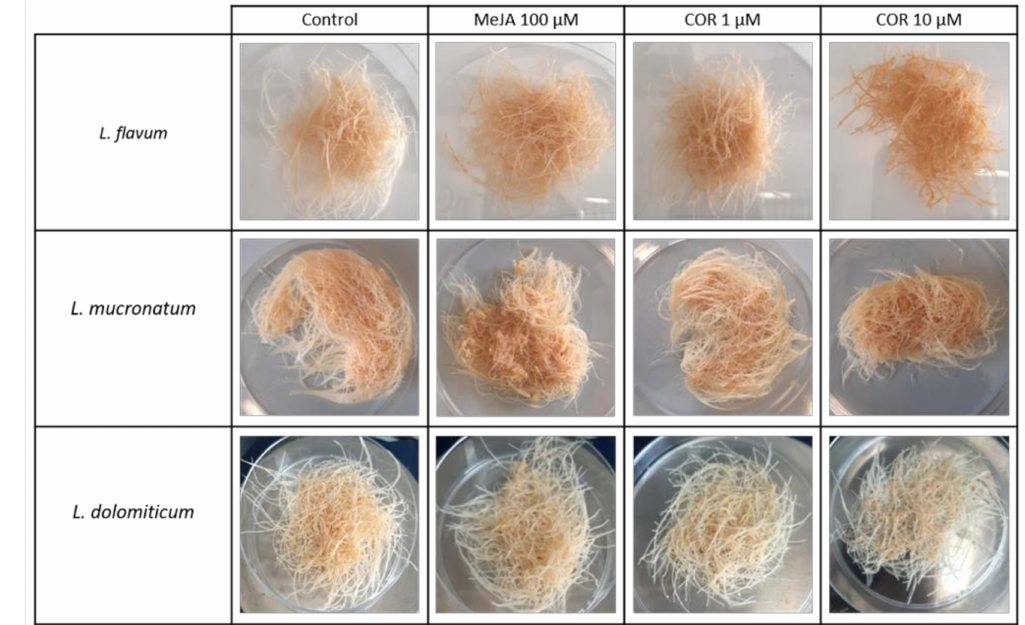
Figure 1. ARc from L. flavum , L. dolomiticum and L. mucronatum grown for 25 days on MS-II medium with or without elicitors: 100 µ M MeJA, 1 µ M COR, 10 µ M COR.